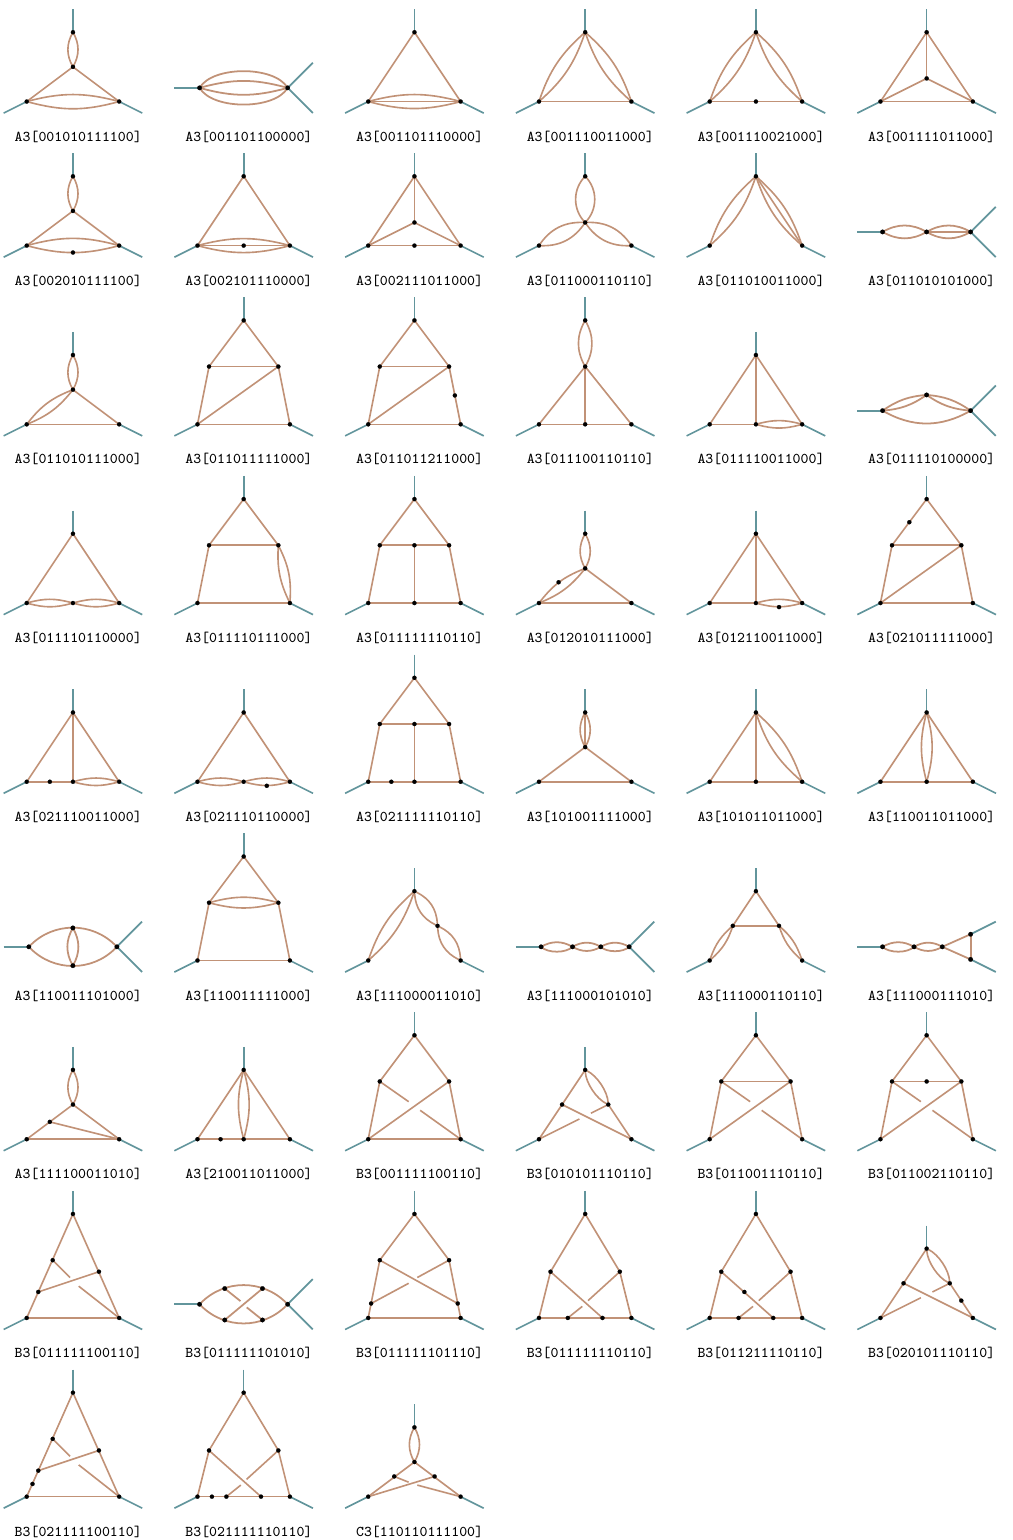
Table 6 . Three-loop master